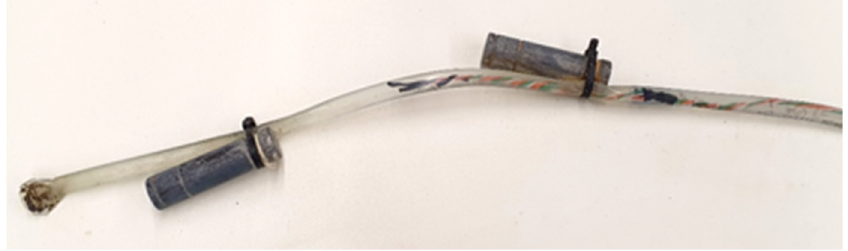
Figure 14. The 1-wire cable protected with an outer tubing and filled with oil Q-Thermie-uniovi-2. Outside of the borehole, the 1-wire bus was connected to a microprocessor Arduino UNO, which supplies power to the sensors and registers the measured data.